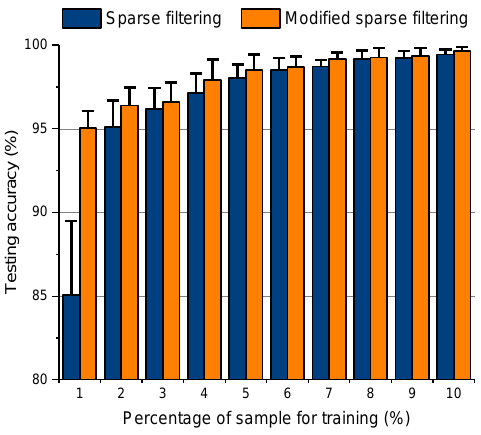
Figure 12. Diagnosis results obtained by different percentages of samples using modified and original sparse filtering.